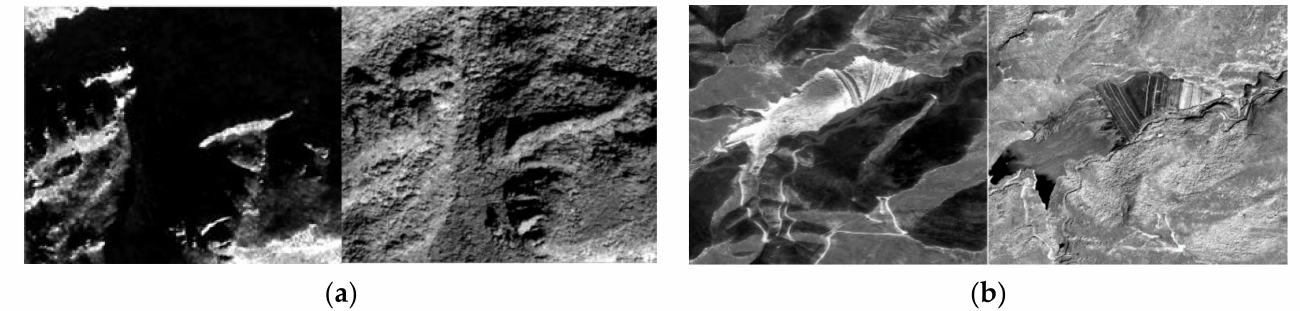
Figure 1. Examples of multi-temporal satellite remote sensing panchromatic images with low-stability and complex terrain: ( a ) mountainous area covered by seasonal vegetation (700 × 850 pixels); ( b ) mine tailings pond (950 × 1100